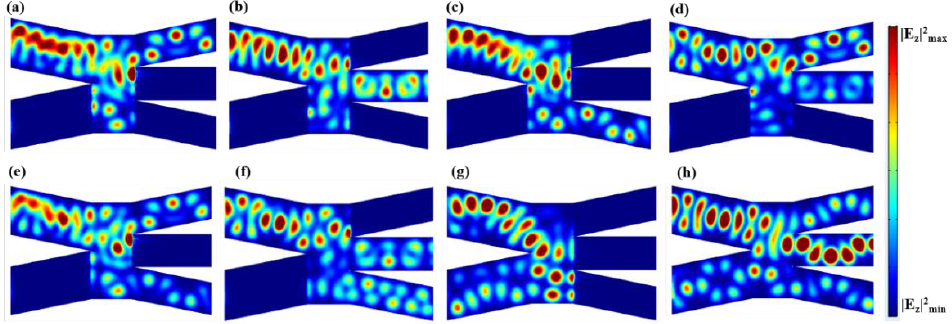
Figure 6. Distributions of |E z | 2 in the x - y plane of the two-input three-output switch. When the input branches “I” and “II” are ON and OFF, respectively, corresponding to input states of “10”, the output branches are in the logical states of ( a ) “100”; ( b ) “010”; ( c ) “001”; ( d ) “110”; ( e ) “101”; and ( f ) “011”. When the input branches “I” and “II” are both ON, corresponding to the input state of “11”, the output branches are in the logical states of ( g ) “000” and ( h ) “111”.